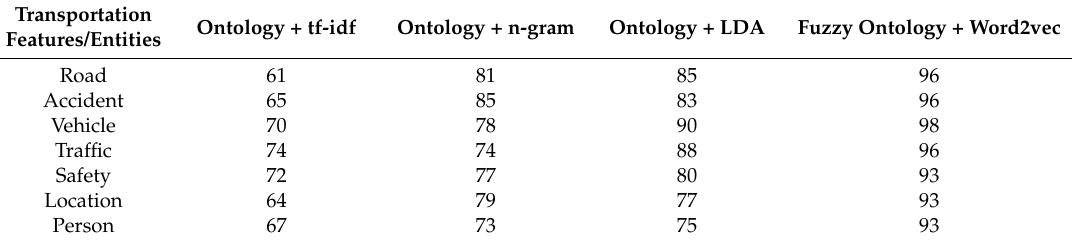
Table 2. The proposed system in comparison with other approaches in terms of feature extraction.